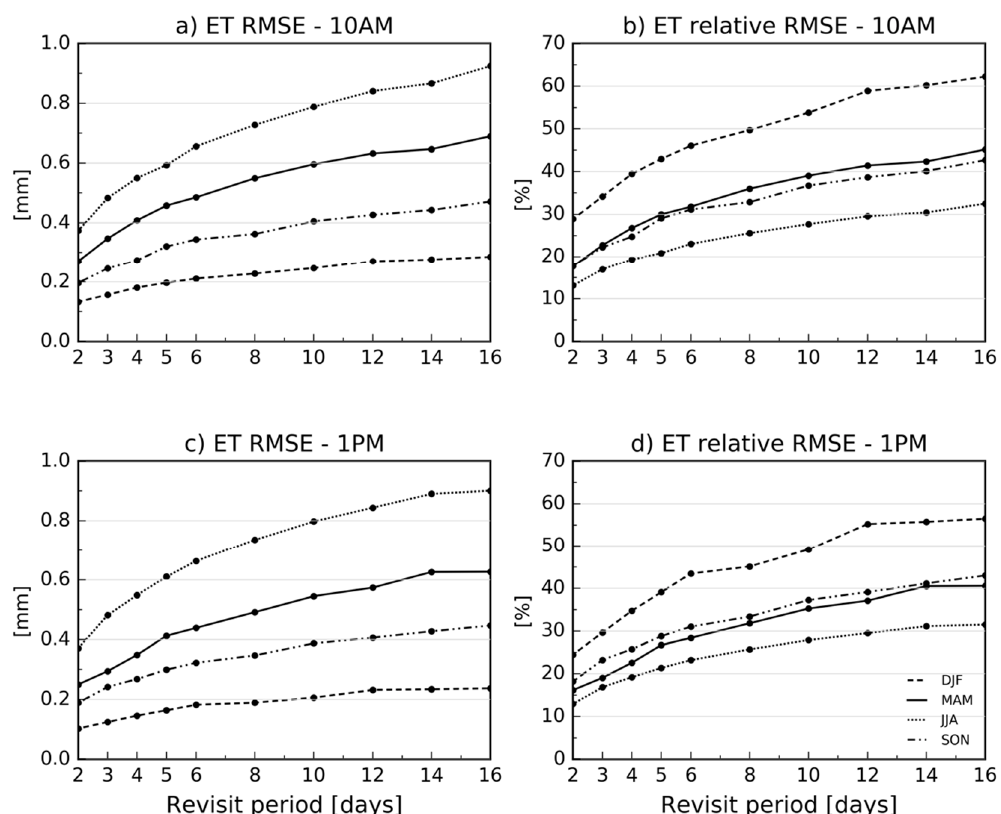
Figure 6. Absolute ( a , c ) and relative ( b , d ) differences—expressed as Root Mean Square difference (RMSE)—between evapotranspiration (ET) derived from the one-day revisit dataset and derived from the different revisit scenarios for a 10:00 ( a , b ) and 13:00 ( c , d ) simulated satellite overpass time. All revisit datasets, including the reference (one-day revisit) were derived from time-of-day clear-sky observations using daytime scaling and interpolation process for the cloudy days. The relative difference represents the ratio between the RMSE and the one-day revisit dataset.